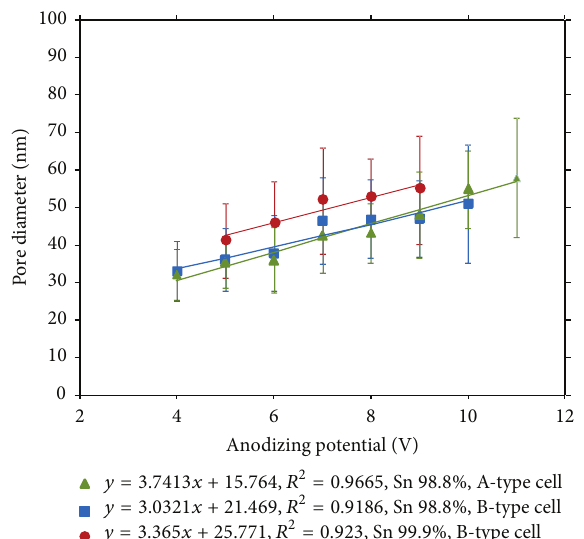
Figure 6: Average pore diameter as a function of anodizing